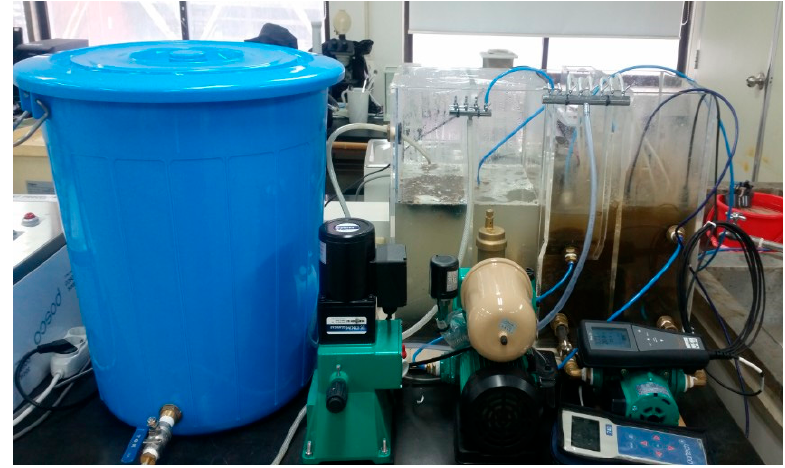
Figure 1. Front view of the shipboard advanced wastewater treatment at a bench-scale.